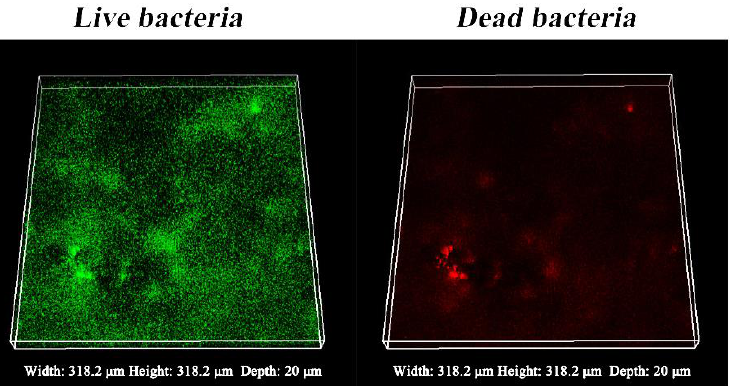
Figure 2. CLSM images of biofilm formed on specimen surface after 14 days of immersion in SRB-inoculated soil